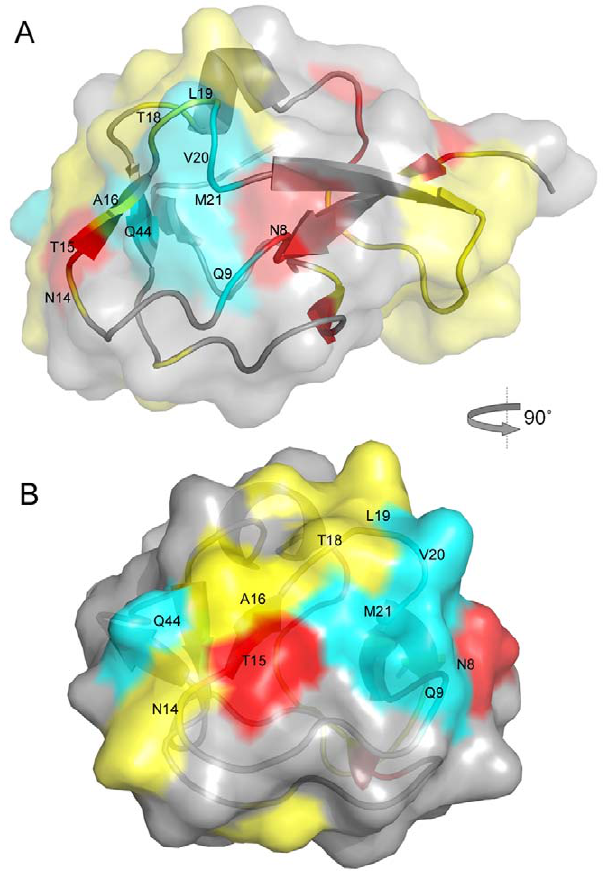
Figure 3. The surface of the eelpout type III AFP (PDB ID 1msi). (A) Key residues selected by the SVMGA are labeled in black